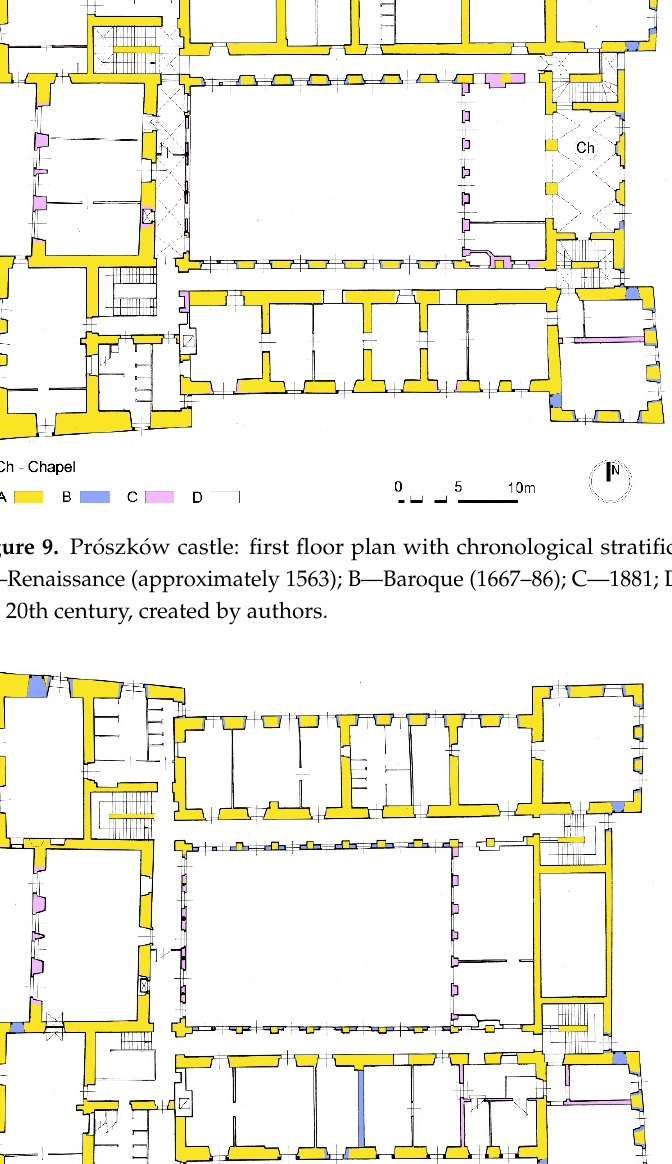
Figure 10. Prószków castle: second floor plan with chronological stratification of the walls. Legend: A—Renaissance (approximately 1563); B—Baroque (1667–1686); C—1881; D—walls unknown and from the 20th century, created by authors.